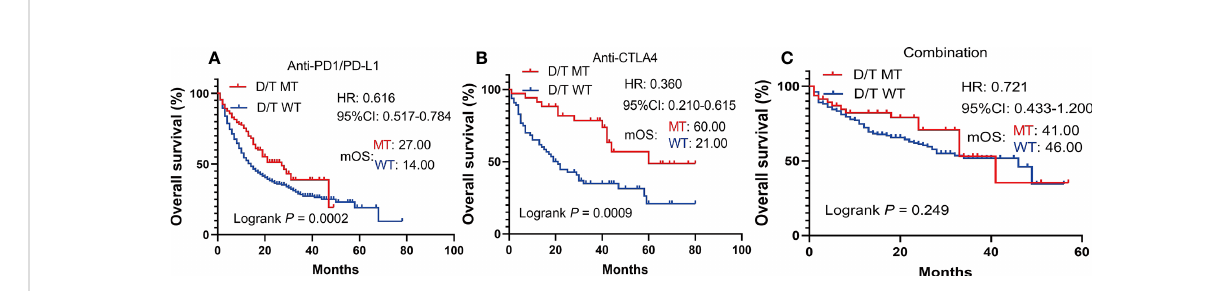
(Figure 6A). In addition, patients who harbor PTPRD/PTPRT mutations had a higher DCB ratio than WT patients (46.77% vs 38.73%) (Figure 6B). On the other hand, the NDB ratio of the WT group was higher (53.23% vs 61.27%) (Figure 6B).